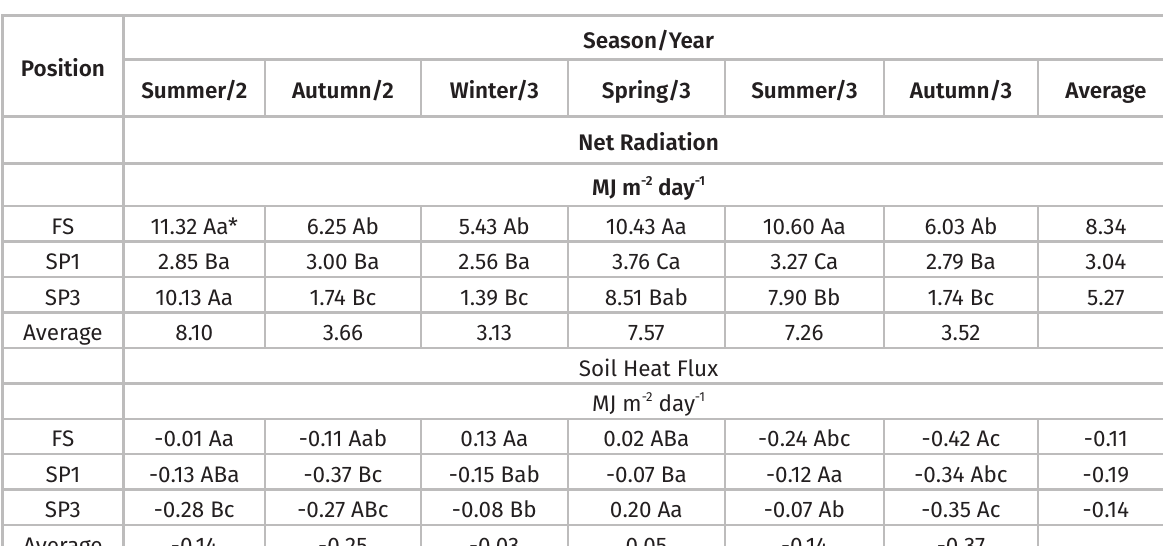
Table V. Net radiation and soil heat flux, at full sun (FS) and at two positions within a silvopastoral system (SP1: 0.00 m and SP3: 7.50 m from the North row), in six